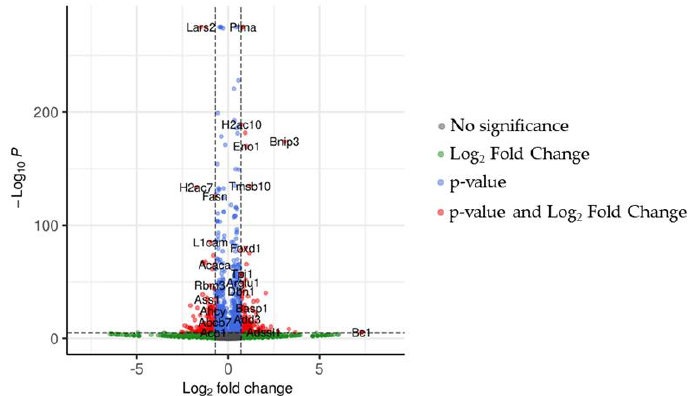
Figure 3. The volcano plot shows the behavior of genes in our analysis. Red and blue dots are the genes with p -values lower than 0.05. Additionally, genes represented by red dots have a fold change higher than 0.7 orders of magnitude. The green dots highlight genes with fold changes over the threshold but, along with the grey dots, without p -value significance.